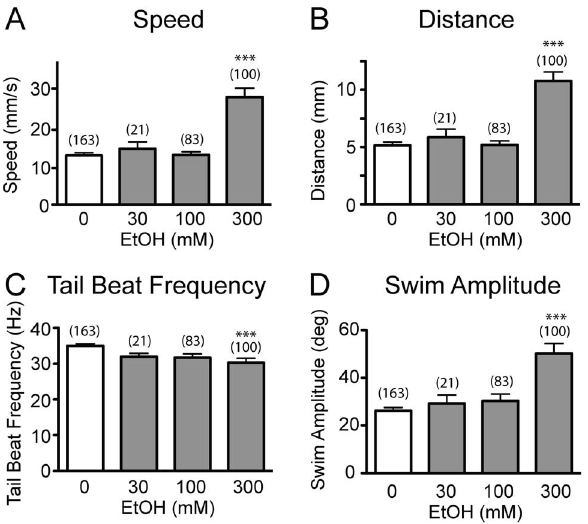
Figure 1. The effects of ethanol on spontaneous locomotion. Spontaneous locomotion kinematics of larval zebrafish (n=20–25) after exposure to 0, 30, 100 and 300 mM ethanol for 30 min. Speed, distance, tail beat frequency, and swim amplitude are shown in A, B, C, and D, respectively. Numbers of analyzed larvae are shown in brackets (***P , 0.001 versus 0 mM ethanol).